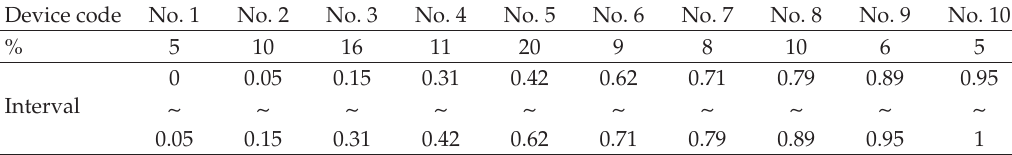
Table 2: Storage percentage of each device relative to the total storage